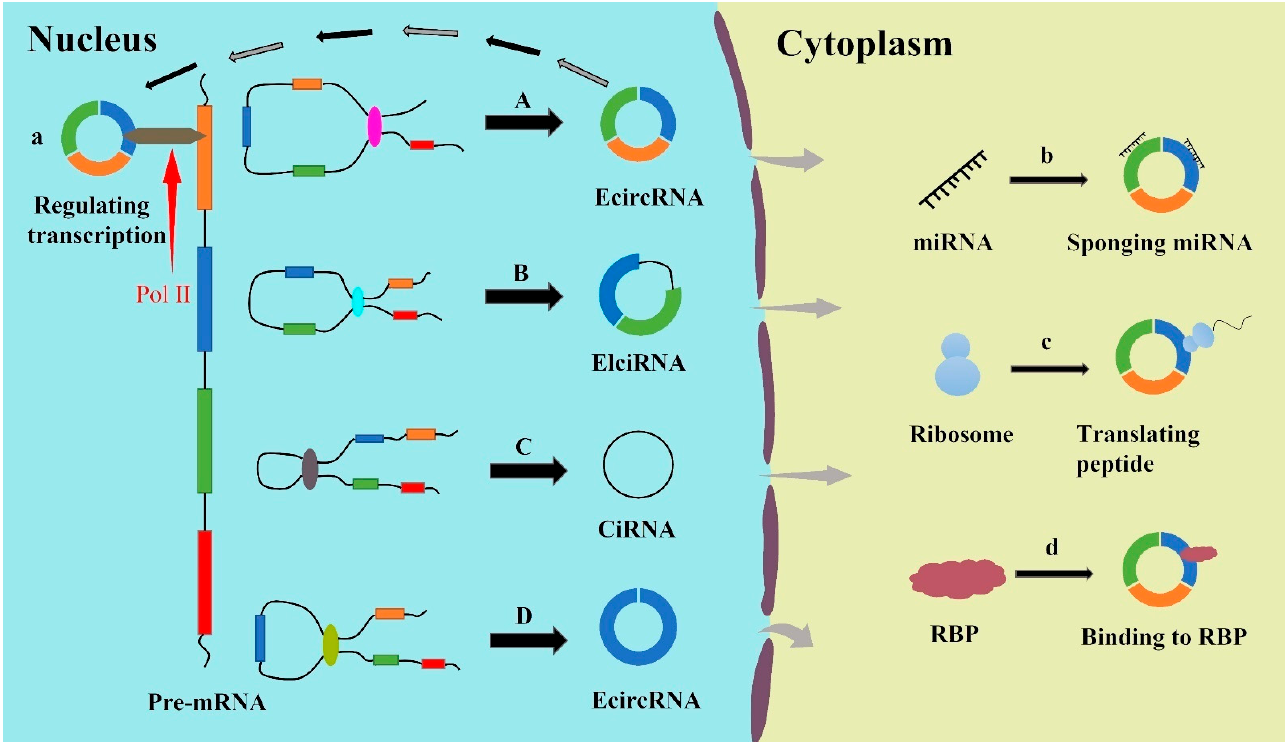
Figure 1. Biogenesis and function of circRNAs .A. EcircRNA is generated from linking the downstream 5 ′ terminal of an exon to the upstream 3 ′ terminal of another exon and cyclizing. B. EIciRNA is formed by intron pairing-driven circularization, which is induced by reverse complementary sequences. C. The formation of CiRNA depends on conserved sequences near the spliceosome. D. EcircRNA can also be generated from a single exon, where the 5 ′ terminal of one exon is connected to the 3 ′ terminal of the same exon. a. Regulation of gene transcription. b. MiRNA sponges. c. Translation into peptides and/or proteins. d. Interaction with functional proteins.